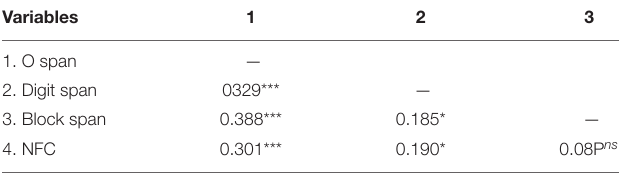
TABLE 2 | Pearson’s